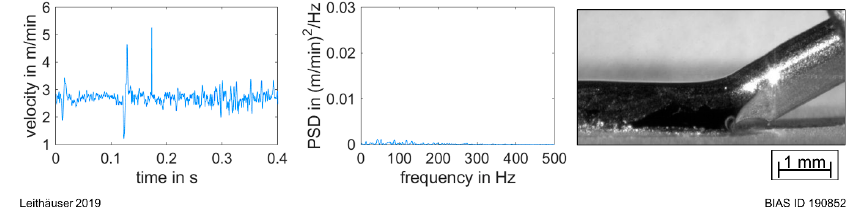
Figure 7. ( Left ) Wire velocity over time, when the wire feeding is uninfluenced by an interaction between the solid (unmolten) wire and the sheet. ( Middle ) PSD of the time signal. ( Right ) Snapshot of the high-speed recording during these events.